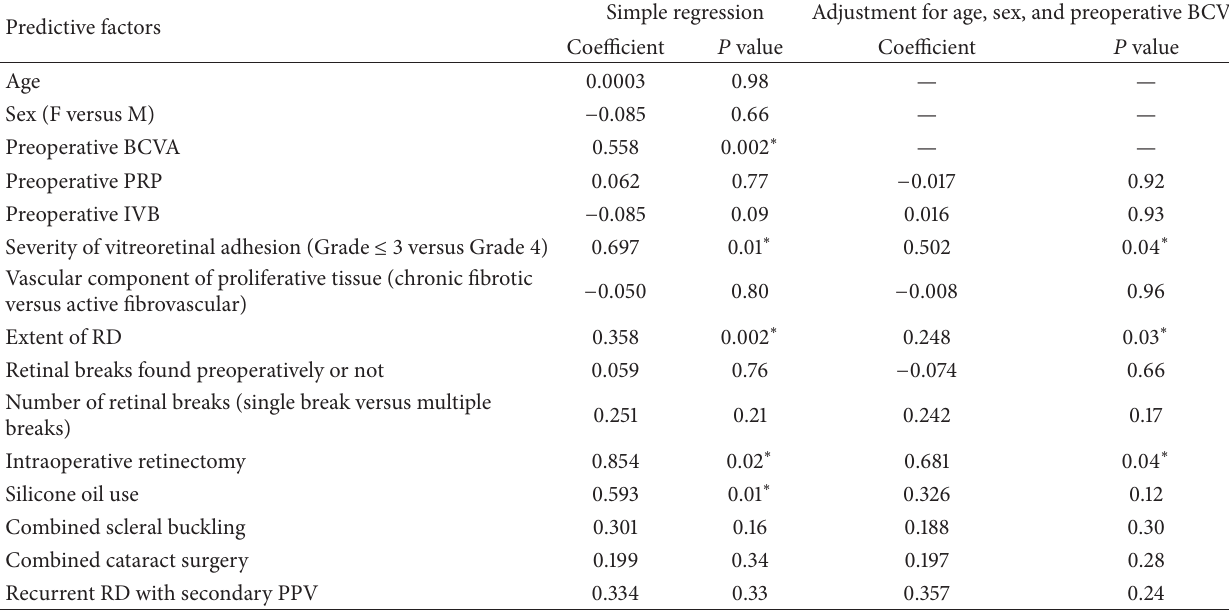
Table 3: Regression analyses of risk factors associated with poor postoperative visual